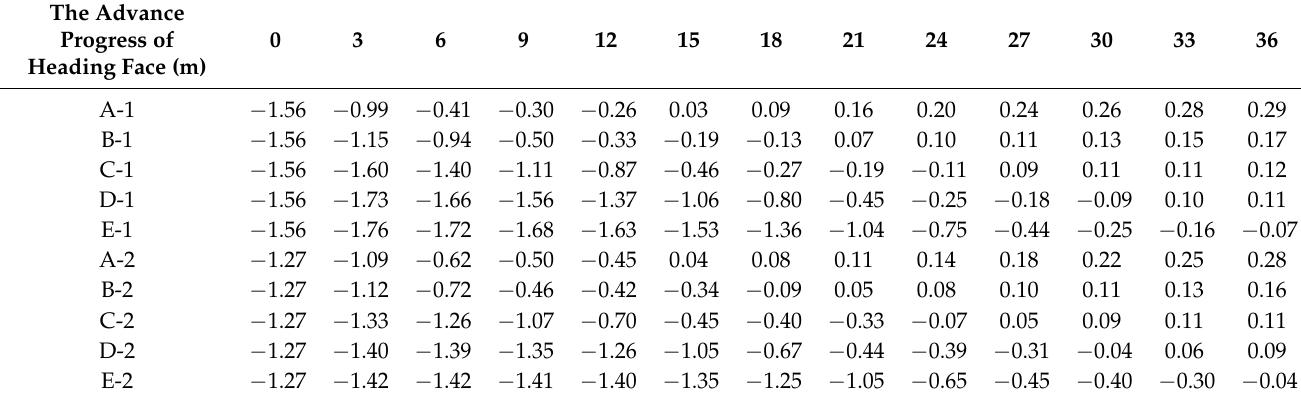
Table 12. Maximum principal stress trend of the second-layer initial support (Unit: MPa).